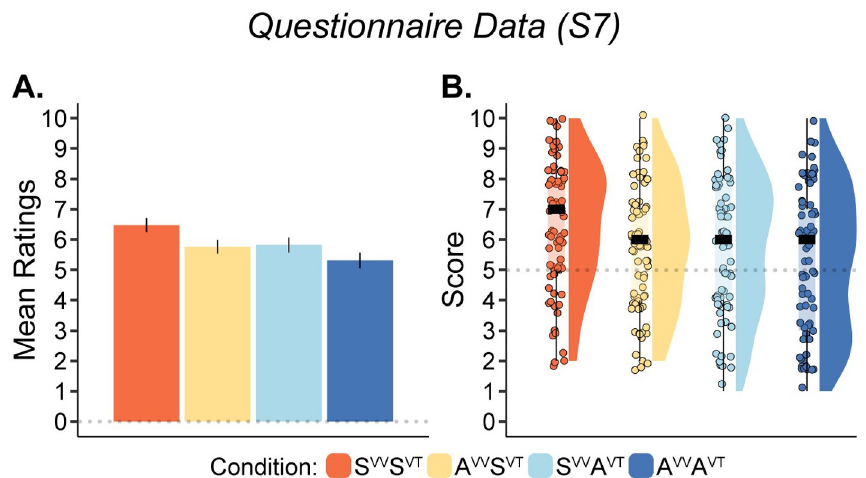
Fig 3. Plots for questionnaire results for statement S7 (N = 80) (“How much motion did you feel? Please indicate”). ( A ). Barplot shows the means and standard error of the mean for illustrative purposes. ( B ). Raincloud plots show individual data points, medians, and distributions. Note: paired comparisons, descriptive statistics and post hoc comparisons are shown in S3 Fig, S3 and S4 Tables of the ‘Supporting Information–Section II’ in S1 File,